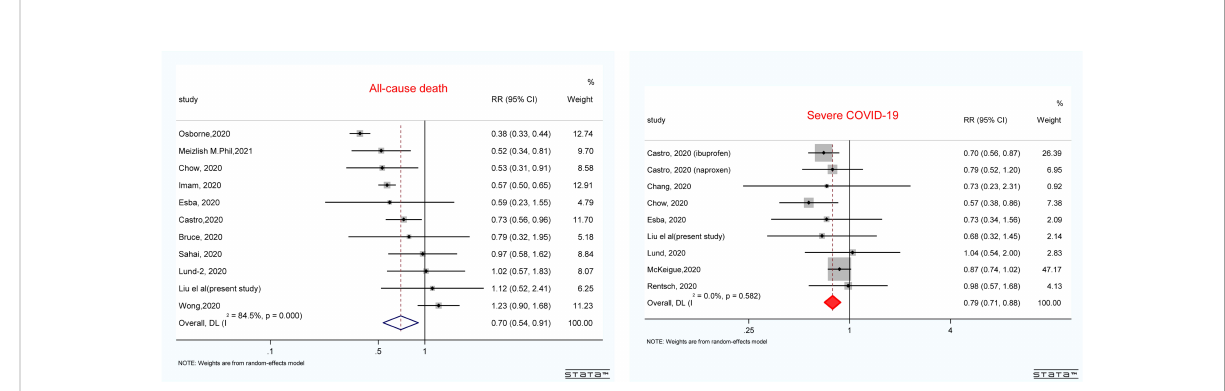
FIGURE 3 Forest plot showing the pooled results of NSAID use and all-cause mortality and disease severity in patients with COVID-19. The results were pooled by using the random effect. RRs greater than 1.0 indicated less favorable outcomes for patients who are NSAID users compared with non-users. COVID-19, coronavirus disease 2019; RR, risk ratio; NSAID, non-steroidal anti-in fl ammatory